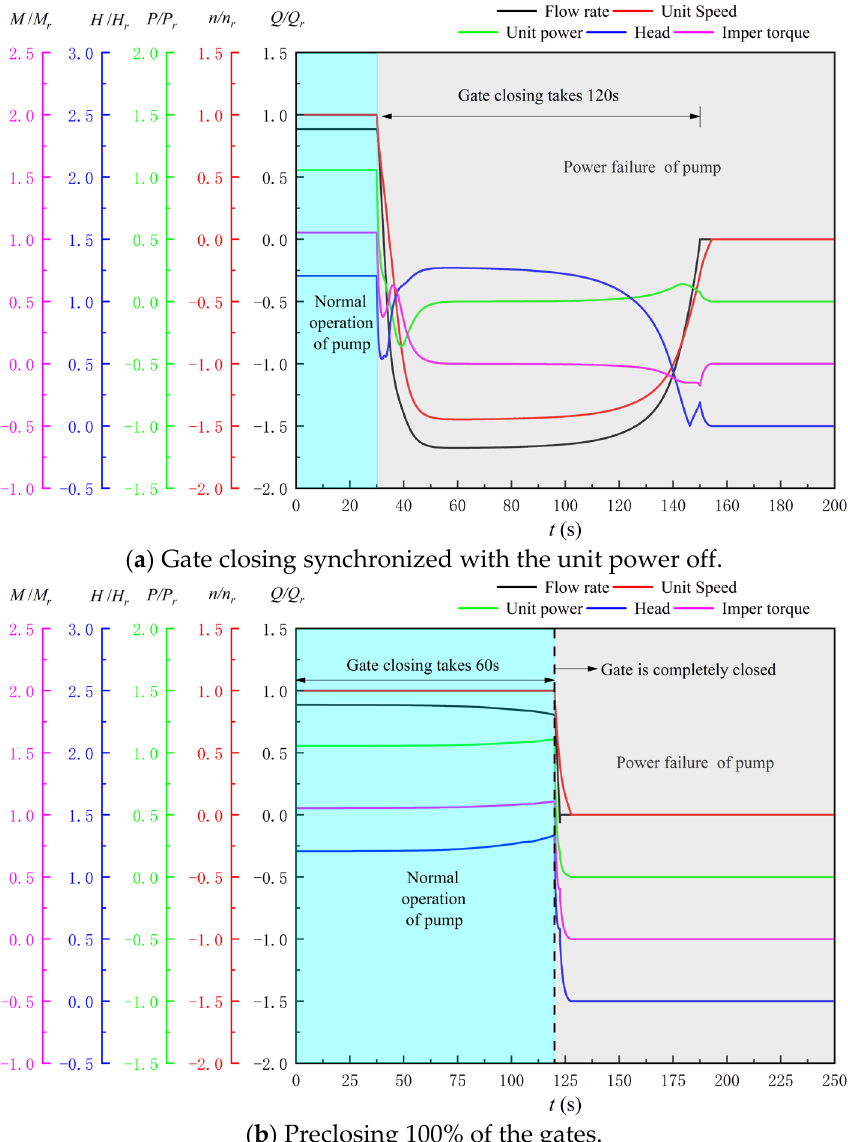
Figure 23. Comparison of the KCPs of the LAPS with synchronous or advance closing of the gate (TTGC: 120 s) .